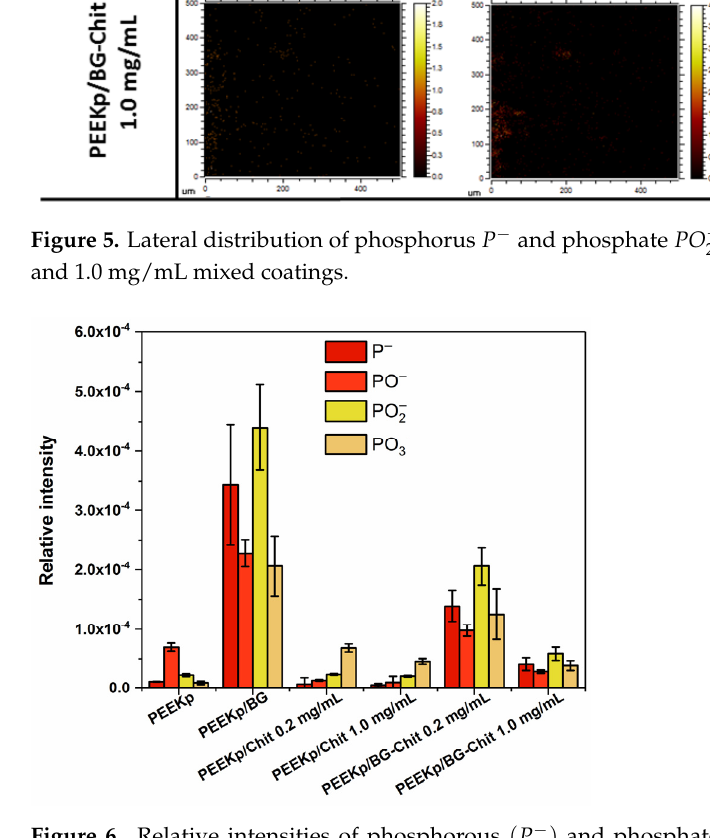
Figure 6. Relative intensities of phosphorous (𝑃 (cid:2879) ) and phosphate (𝑃𝑂 (cid:2879) , 𝑃𝑂 (cid:2870)(cid:2879) , 𝑃𝑂 (cid:2871)(cid:2879) ) moieties determined on the modified PEEK surfaces.